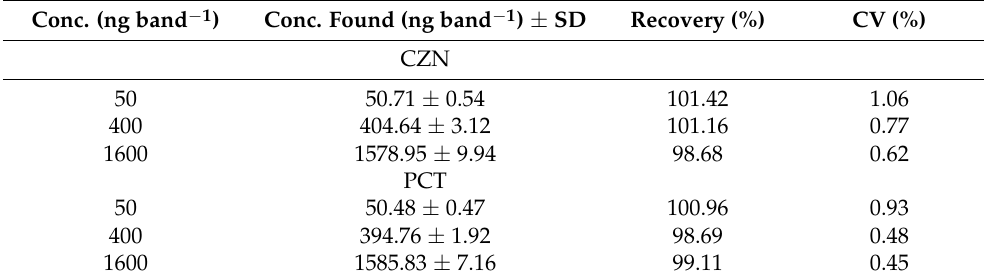
Table 3. Determination of the accuracy of CZN and PCT for the HPTLC-UV methodology (mean ± SD; n =